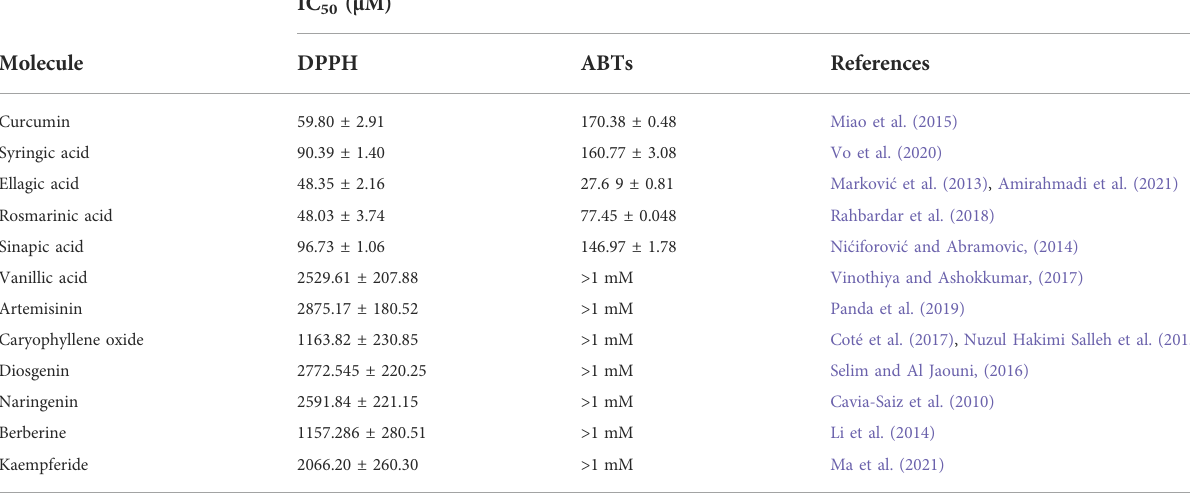
TABLE 1 The in vitro antioxidants activities of natural molecules (Cur, Ros-A, Ella-A, Syr-A, and Syn-A) using DPPH and ABTS assays. The activity was expressed by IC 50 and data presented as mean ± SD ( n > 3). Different letters indicate signi fi cant differences among treatment at p < 0.05. IC (µM) 50 Molecule